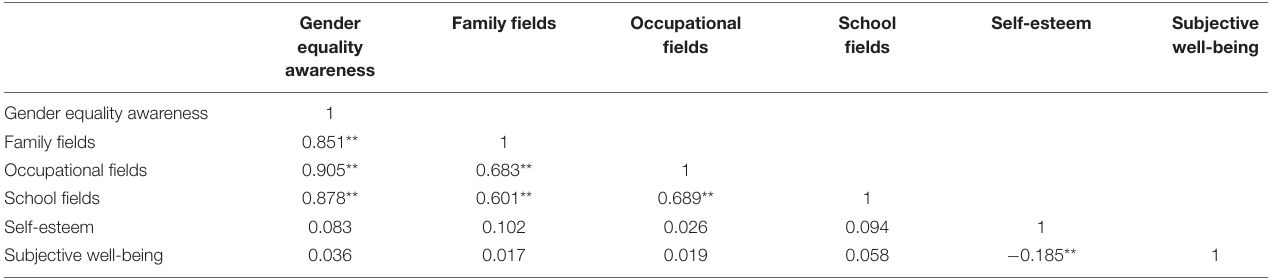
TABLE 3 | Correlations among the measured variables ( N =